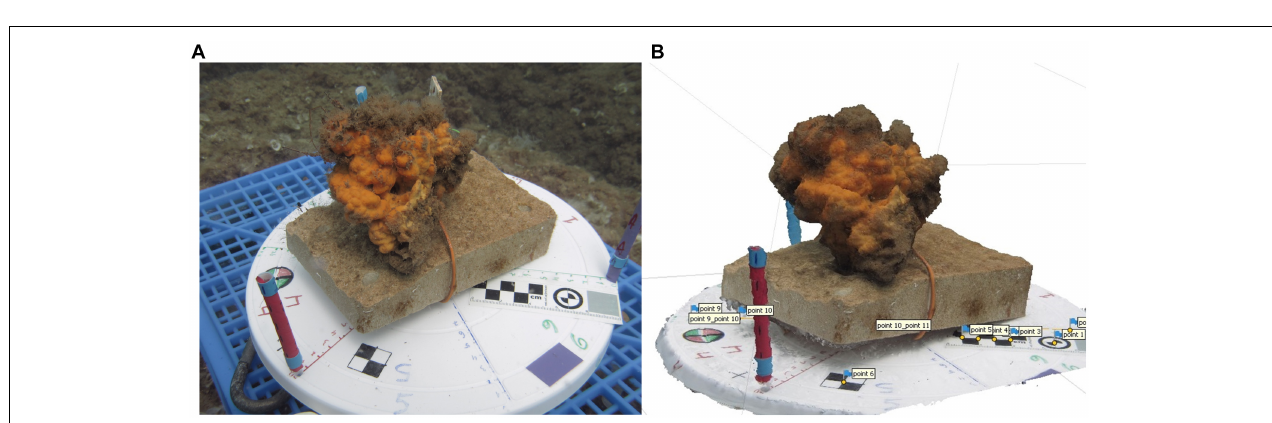
FIGURE 1 | Transplanted A. oroides . (A) specimens transplanted to the shallow site placed both inside and outside the plastic crates; (B) specimens transplanted to the deep site, placed on a metal tray.